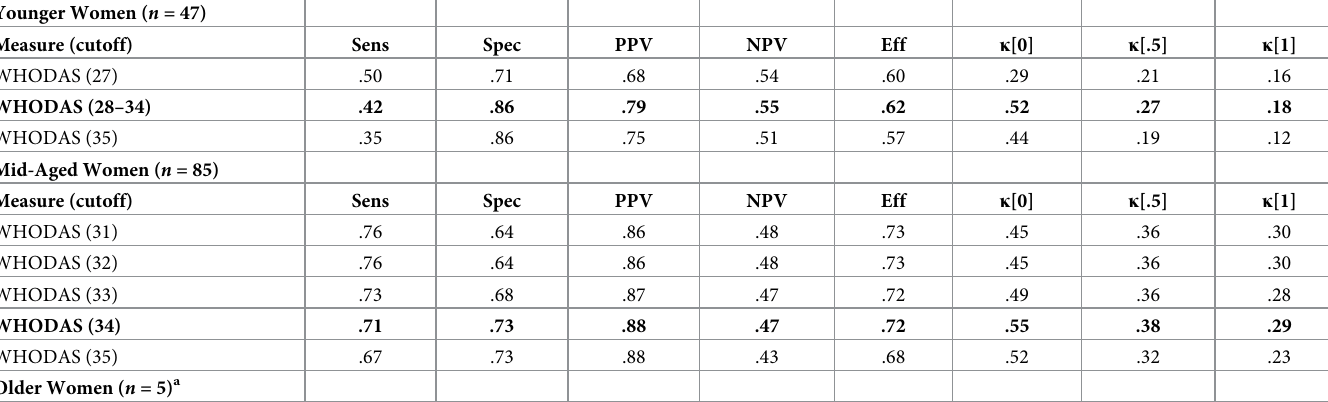
Table 5. Diagnostic utility of WHODAS total score for predicting functional impairment on the CAPS (either IV or 5) among younger, mid-aged, and older women. Younger Women ( n = 47) Measure (cutoff) Sens Spec PPV WHODAS (27)